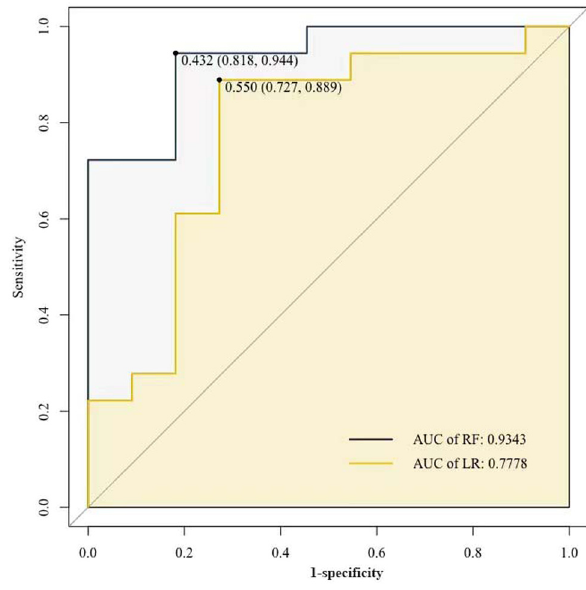
Figure 4: The ROC curve of predictive models for distinguish PBC with OS. RF, random forest; LR, logistic